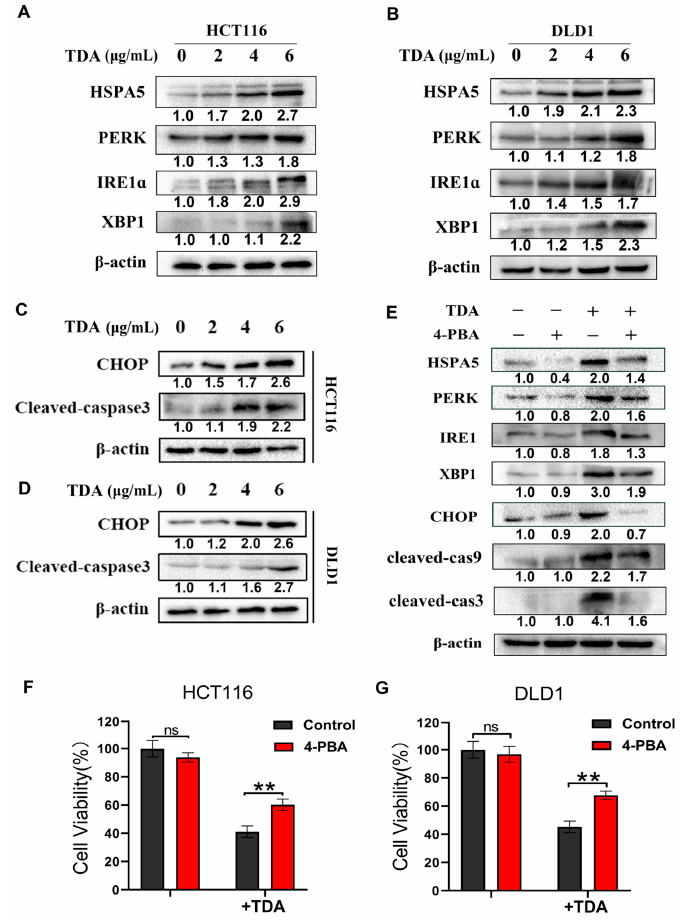
Figure 4. TDA activates ER stress response to induce apoptosis in colon cancer cells. ( A , B ) Western blot detection of the expression of HSPA5, PERK, IRE1 α and XBP1 in HCT116 and DLD1 cells treated with the indicated concentrations of TDA for 24 h. ( C , D ) The protein expression levels of CHOP and cleaved Caspase 3 in TDA-treated HCT116 ( C ) or DLD1 ( D ) cells were detected by Western blot. ( E ) Western blot detection of the expression of HSPA5, PERK, IRE1 α and CHOP as well as cleaved Caspase 9 (cleaved-cas9), cleaved Caspase 3 (cleaved-cas3) in HCT116 cells treated with or without 6 µg/mL TDA in the presence or absence of 2 mM 4-phenylbutyrate (4-PBA) for 24 h. ( F , G ) Cell viability in HCT116 or DLD1cells treated with 4-PBA or TDA alone or together was measured by CCK-8 assay. Western blot results were quantified using Image J software, and the results were numerically marked below each band. Data are presented as the mean ± SD from three separate experiments. ns, no statistical significance; ** p <